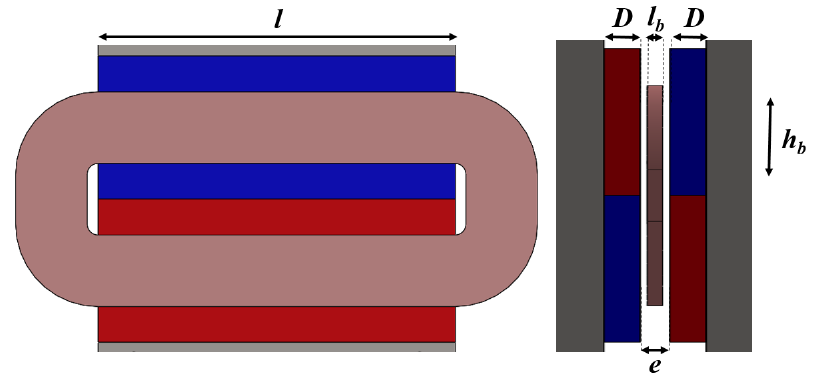
Figure 9. Actuator side and front views: parameters used during